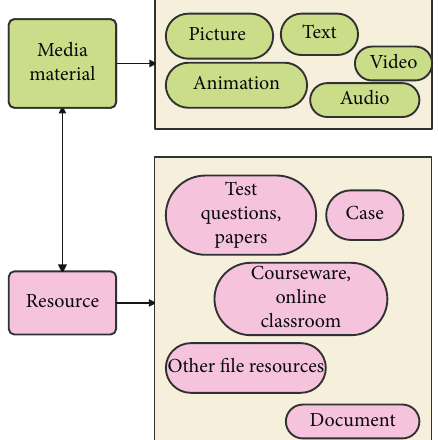
Figure 2: Classification of online teaching resources of spoken English.